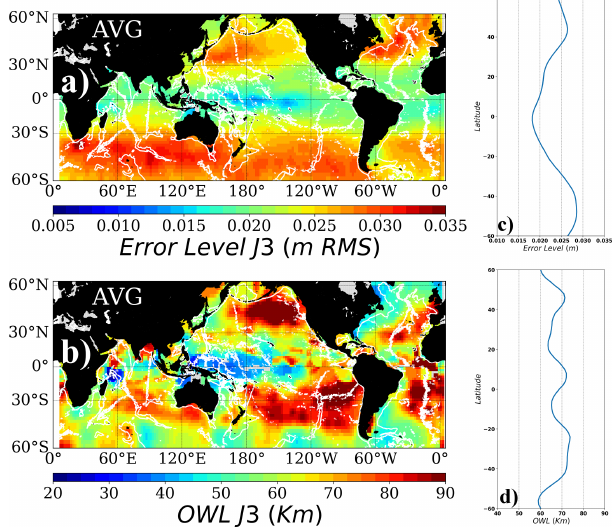
Figure 1. (a) Average spectral noise level in meters rms and (c) its zonal average for Jason-3. Noise level is computed as the average PSD value between 15 and 30km wavelength. (b) Observable wave- length, or the wavelength for a signal-to-noise ratio equal to 1 (in km), and its zonal average (d) . The observable wavelength is com- puted as the intercept wavelength for the mesoscale spectral slope and the noise level. White contours represent the topography at 3000m depth.